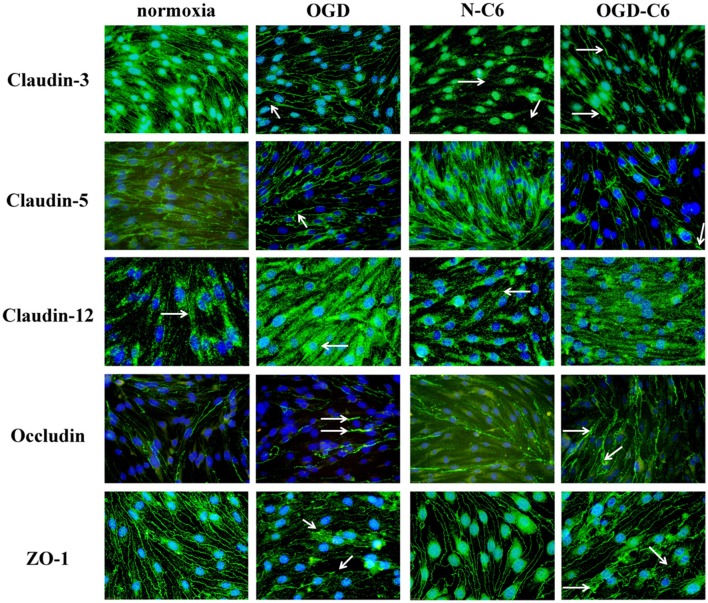
Representative immunofluorescence images of tight junction proteins of cerebENDs treated for 4 h under normoxic or OGD conditions in the presence or absence of astrocyte soluble factors. Normoxia, cerebEND normoxic control for 4 h; OGD, cerebENDs treated under OGD conditions for 4 h; N-C6, cerebENDs treated for 4 h with C6 conditioned medium derived from C6 cells which were treated under normoxic control conditions for 4 h; OGD-C6, cerebENDs treated for 4 h OGD with C6 conditioned medium derived from C6 cells which were treated under OGD conditions for 4 h. White arrows indicate lost tight junctions strands in case of claudin-3 N-C6, broadened tight junctions strands after OGD and OGD-C6 in case of claudin-3, claudin-5, and occludin, broadening and leaks in tight junction strands of ZO-1 OGD and OGD-C6 and non-continuous tight junction strands in case of claudin-12.